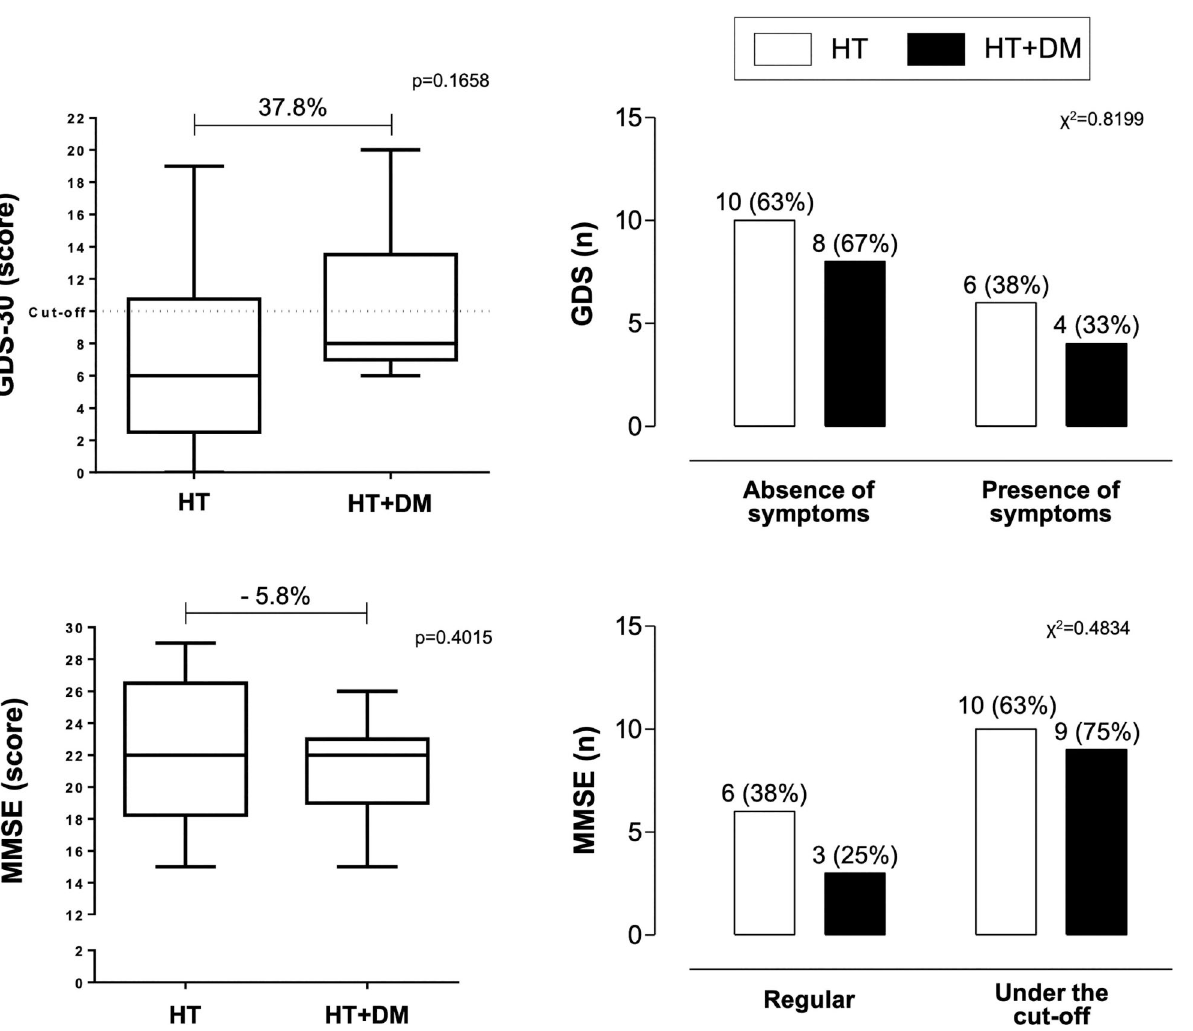
Figure 1 - Cognitive screening and depressive symptoms in hypertensive and diabetic women physical activity practitioners. HT: Hypertensive group; HT + DM: Hypertensive-diabetic group; GDS-30: Geriatric Depression Scale; MMSE: Mini-Mental State Examination. Chi-square test (dichotomous categorical variables) and Mann-Whitney test (categorical